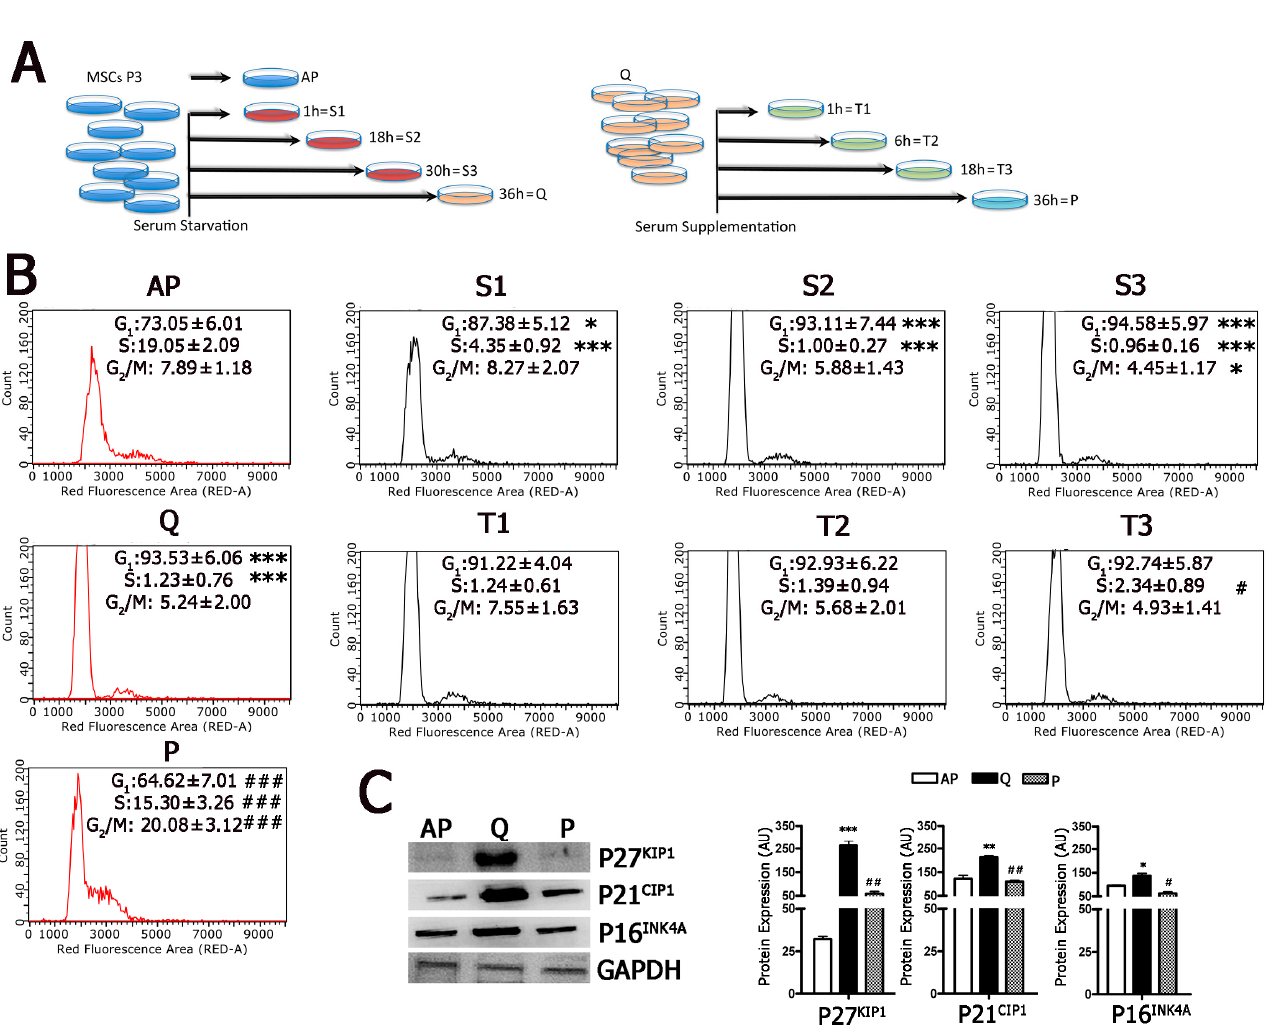
Figure 1. Follow-up of cell-cycle exit and cell-cycle re-entry. Panel ( A ): Graphic summary of the experimental procedure. MSCs at passage 3 (P3) were serum starved for 36 h and, at different time points (AP, S1, S2, S3, Q), cell samples were collected for analysis. Cells were then incubated in a medium containing serum and were cultivated for another 36 h. At different time points (T1, T2, T3, P), samples were collected for evaluation. Panel ( B ): Cell-cycle profiles of MSC samples collected at different time points during starvation and serum re-supplementation. The * indicates the statistical difference between AP, chosen as reference, and S1, S2, S3, and Q (* p < 0.05, ** p < 0.01, *** p < 0.001). The # indicates the statistical difference between Q, chosen as the reference, and T1, T2, T3, and P (# p < 0.05, ## p < 0.01, ### p < 0.001). Panel ( C ): Western blots of MSC samples collected at different time points during starvation and serum re-supplementation. The graphs show the quantification of Western blot bands performed by using GAPDH as the loading control. The * indicates the statistical difference between AP, chosen as the reference, and Q (* p < 0.05, ** p < 0.01, *** p < 0.001). The # indicates the statistical difference between Q, chosen as the reference, and P (# p < 0.05, ## p <